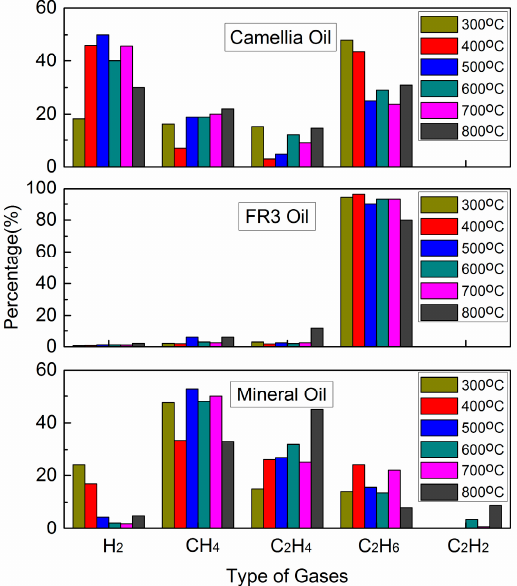
Figure 10. Relative percentages of fault gases in oil ‐ paper insulation as a function of oven temperature (from 300 °C to 800 °C).